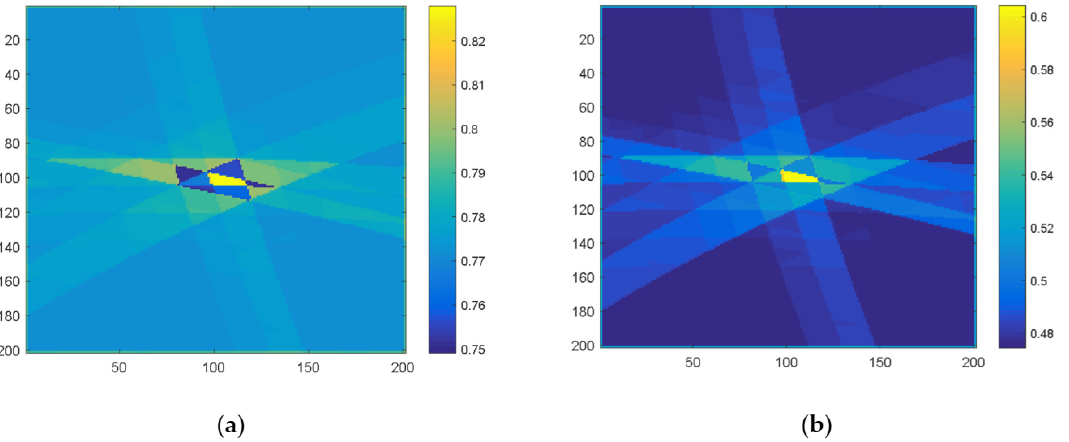
Figure 10. The intermediate variables in the multi-source fusion process. ( a ) The weight distribution of the contrast ratio based on the sliding window; ( b ) The exponential weighted likelihood ratio distribution corresponding to the fusion